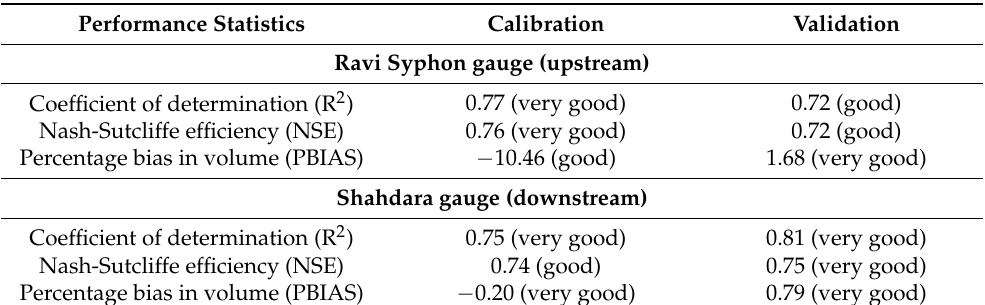
Table 4. SWAT model performance for calibration and validation at Ravi syphon and Shahdara